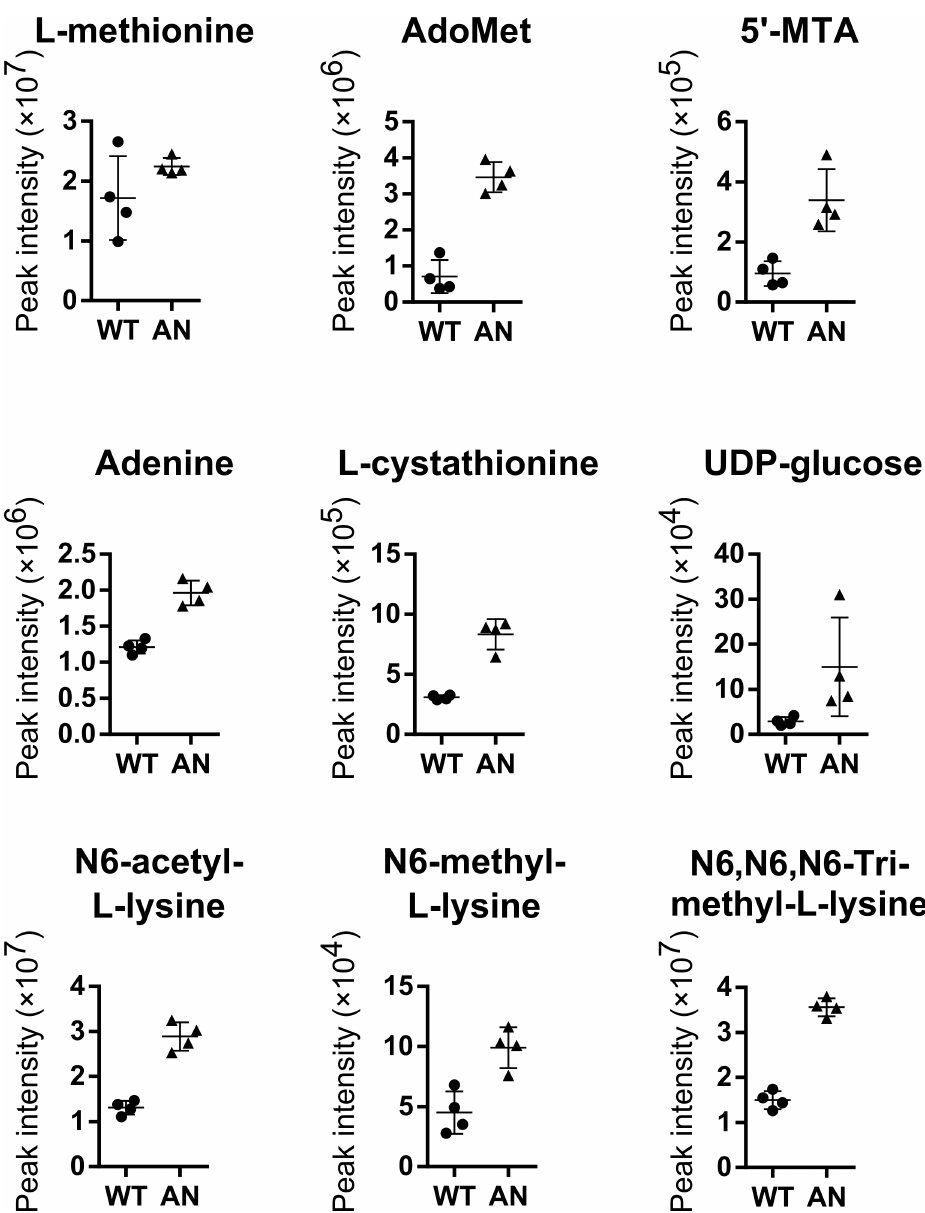
Fig 2. Metabolic changes in PCF T . b . brucei after AN5568 treatment. Plots of individual metabolites perturbed after AN5568 treatment. WT; wild-type untreated, AN5568; wildtype treated for eight hours at 15 μM (10x EC 50